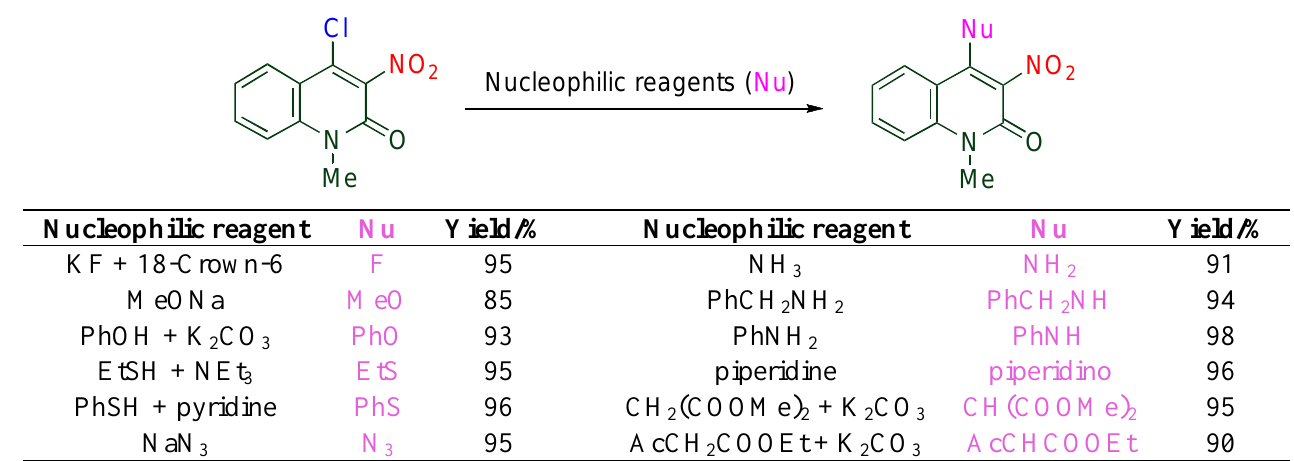
Table 5. Nucleophilic substitution of